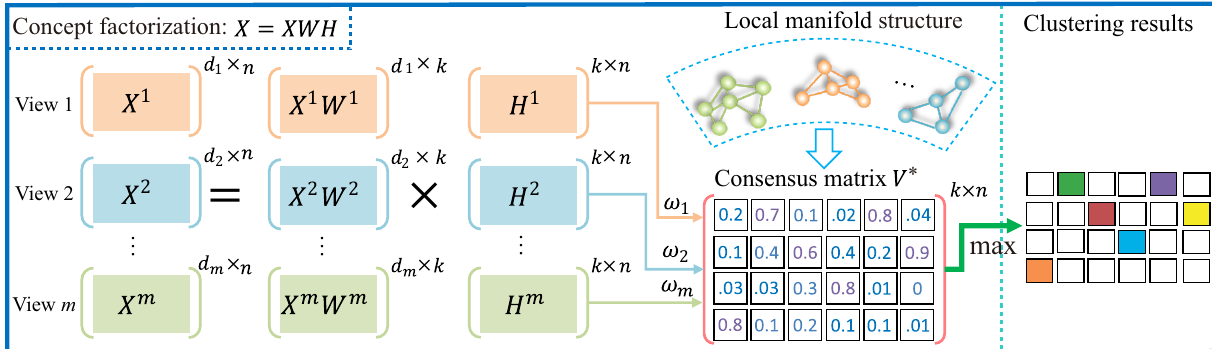
Fig. 11 The graphic presentation of the MvCC